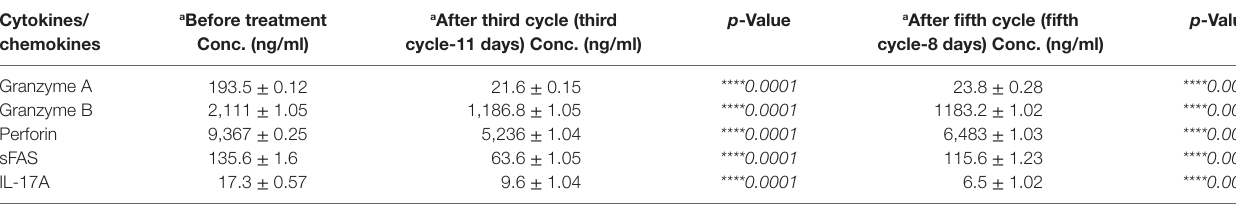
taBle 2 | Plasma concentrations of downregulated cytokines/chemokines after nivolumab treatment. Cytokines/